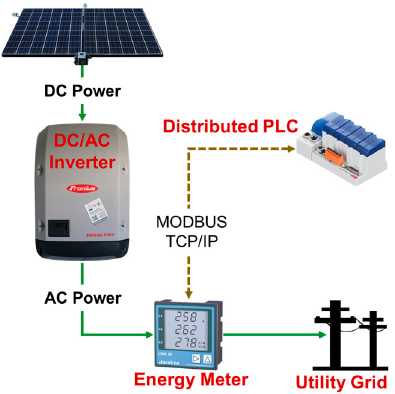
Figure 3. Monitoring mechanism of the PV system to be integrated in the proposed model.